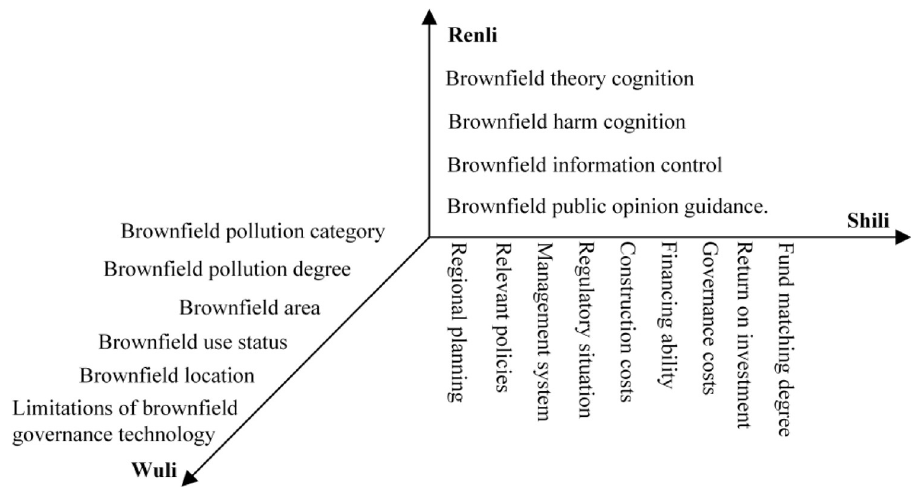
Fig 3. Evaluation index system of brownfield redevelopment based on the WSR system